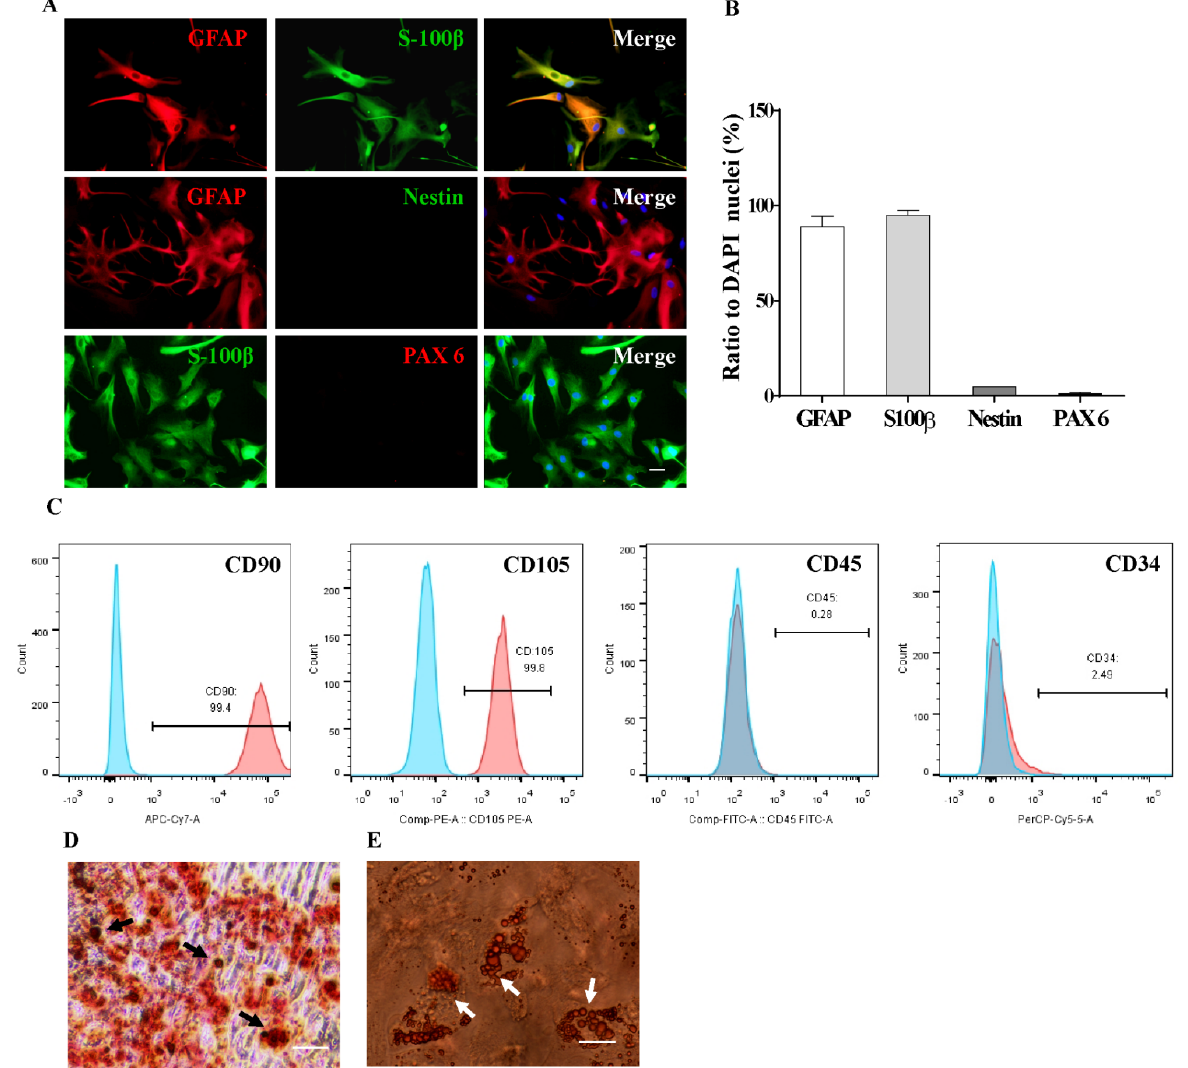
Figure 1. Characterization of primary cultured AS and MSCs. ( A ) Immunostaining analysis showed that nearly 95% of cells in the primary AS culture were immuno-positive for astrocytic markers GFAP and S-100 β , only a small percentage of cells expressed makers for neural progenitor Nestin and PAX6. ( B ) Statistical analysis showed that the overwhelming majority of cells in the primary AS culture expressed astrocytic markers ( n = 3 independent experiments). ( C ) MSCs were stained with surface markers CD90, CD105, CD45, and CD34 and subjected to flow cytometry analysis. More than 99% of cells are immunoreactive to mesenchymal stem cell markers CD90 and CD105 and negative for hematopoietic markers CD45 and CD34. ( D ) The osteogenic differentiation of MSCs was evaluated by Alizarin red staining. Note that the black arrows indicate the calcified tubercles. ( E ) The lipogenic differentiation of MSCs was detected by oil red staining, and the white arrows indicate lipid droplets. Scale bars: 20 µm in ( A ), 50 µm in ( C , D ). Numerical data represent mean ± SEM.